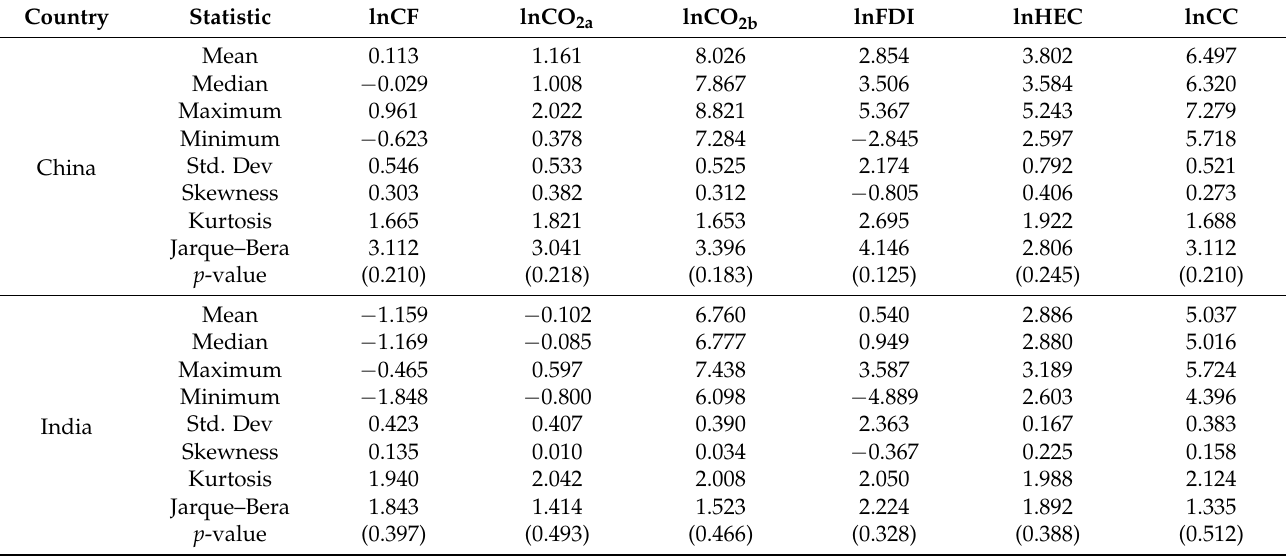
Figure 1. Visual representation of the variables. Table 3. Descriptive statistics and normality